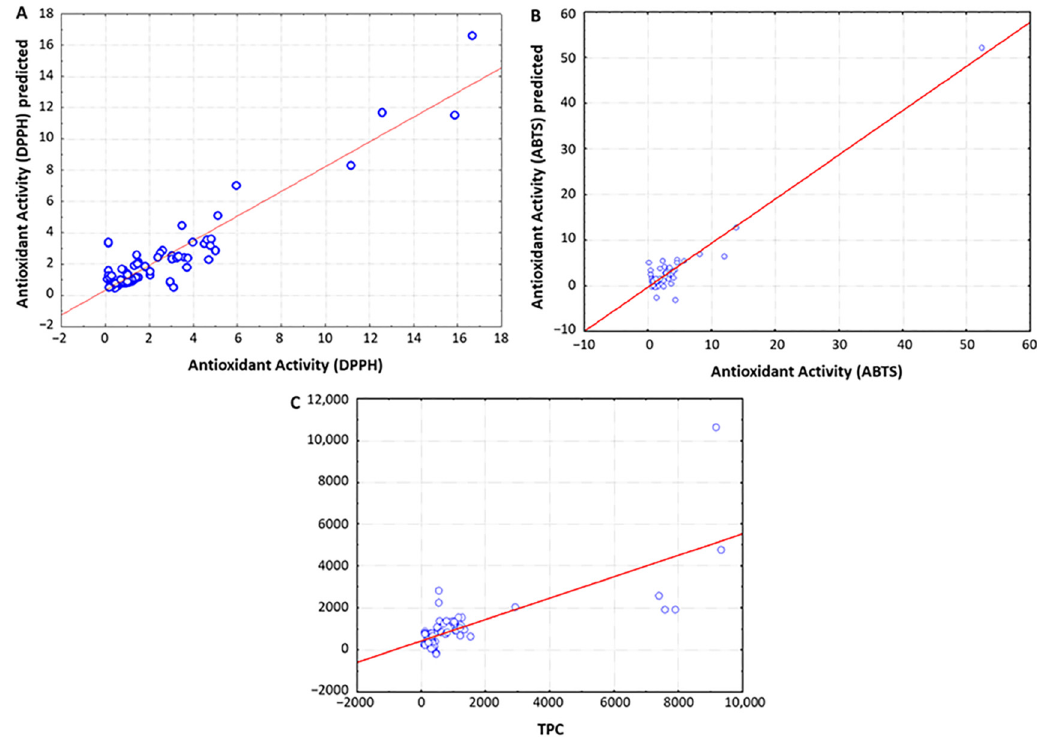
Figure 3. Partial least squares regression (PLSR) analysis for predicting the antioxidant activity measured through the DPPH assay ( A ) and the ABTS assay ( B ), as well as the total phenolic content ( C ) of vinegars using UV-Vis spectral data.